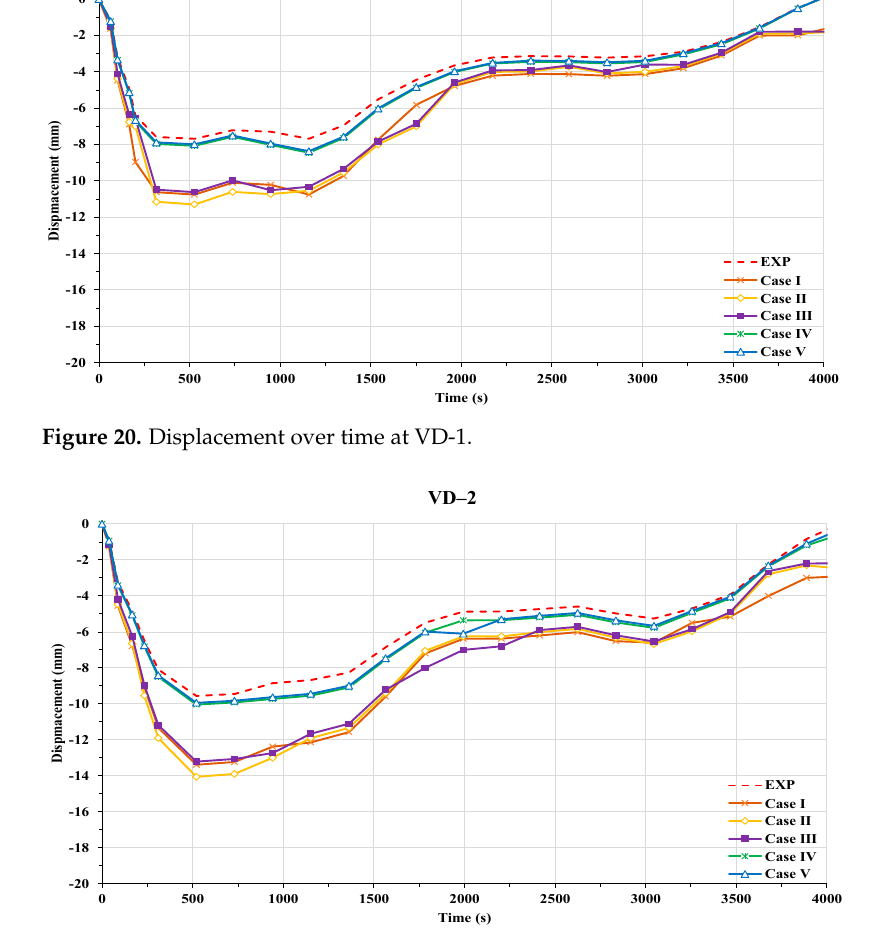
Figure 22. Displacement over time at VD-3. Figure 23. Deflection at 4000 s and maximum deflection versus time increments ( ∆𝑡 ) at VD-1.